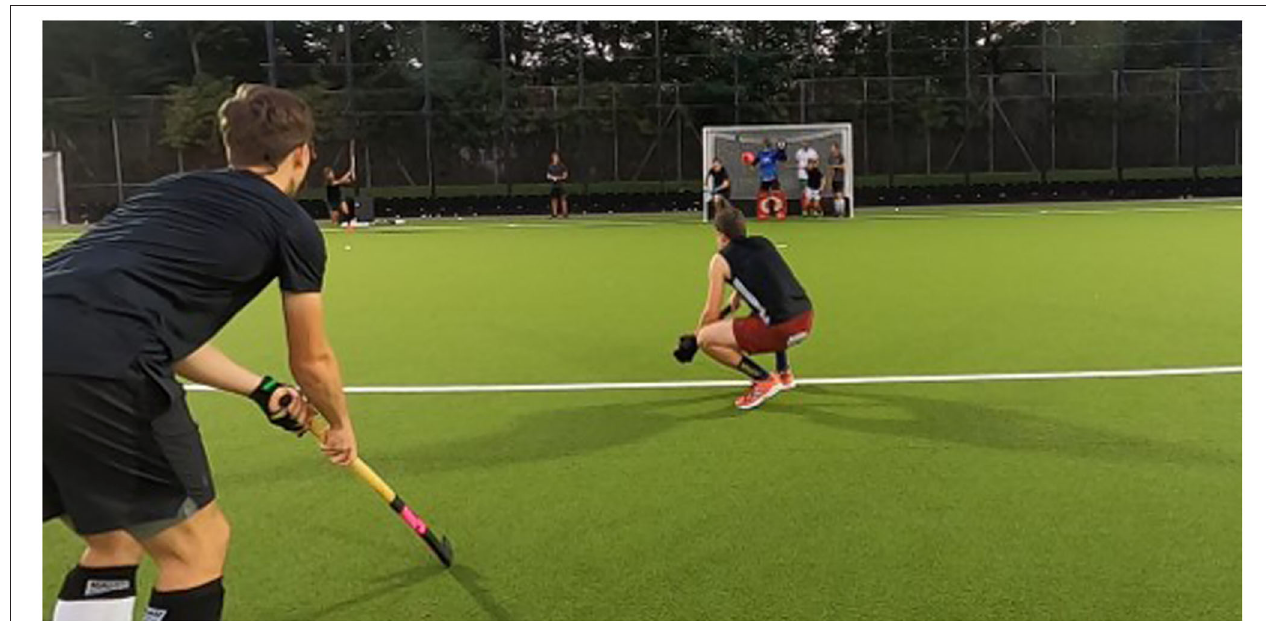
FIGURE 3 | Depiction of field testing from the perspective behind the striker showing the striker (standing) and stopper of the offensive team in the foreground and the defenders and goalkeeper inside the goal before running out just after the injector (far left from the goal) has played the